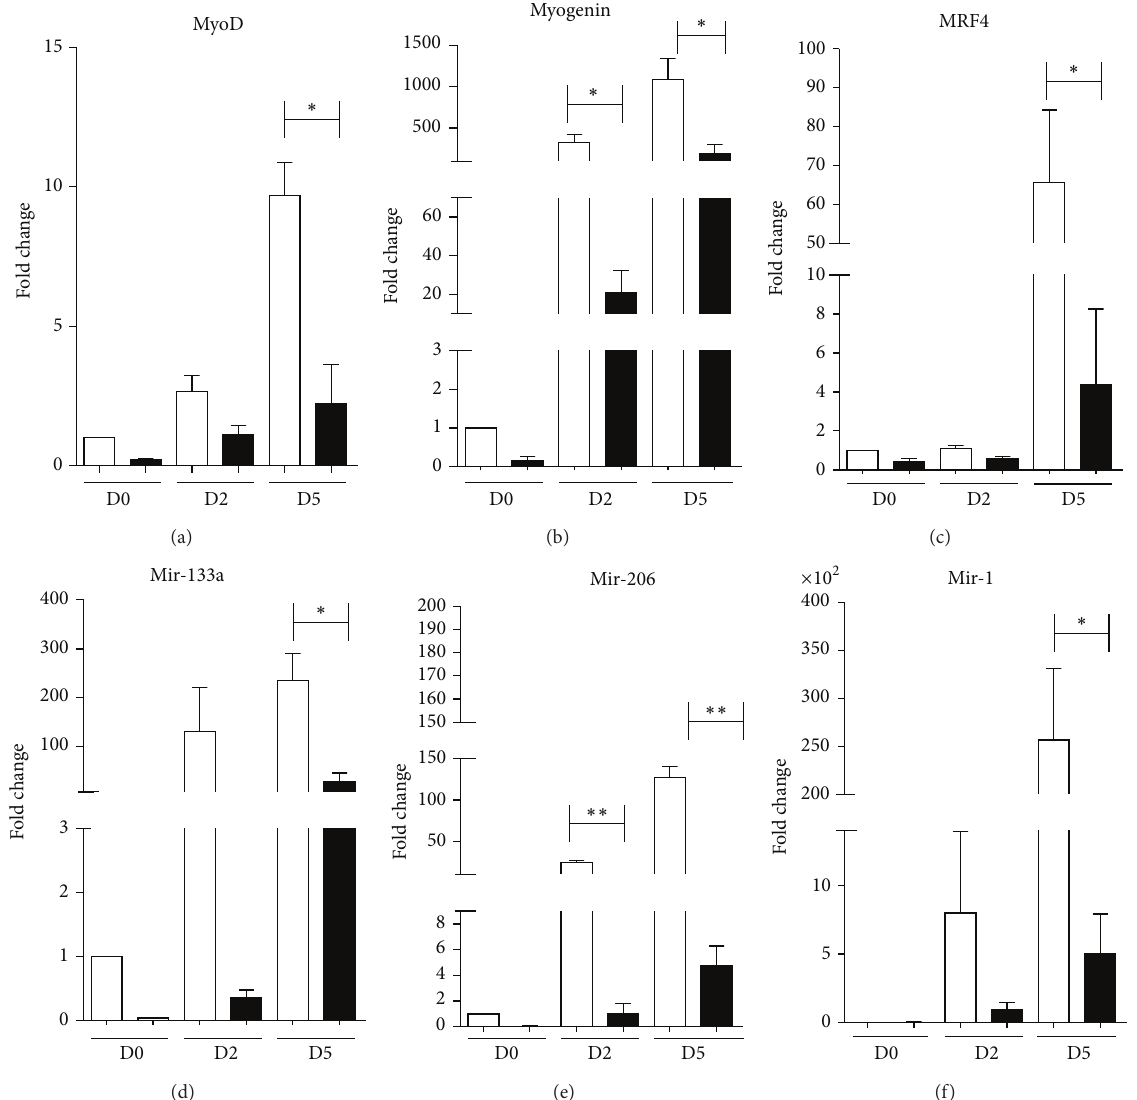
Figure 3: Mutant SOD1 gene downmodulates the players involved in C2C12 differentiation. Real time PCR for MyoD (a), Myogenin (b), MRF4 (c), miR133a (d), miR206 (e), and miR1 (f) in both control (white bars) and transfected cells (black bars). D0, D2, and D5 referred to days of culture in differentiation condition. Data are represented as mean ± SEM ( ∗ 𝑃 < 0.05 ; ∗∗ 𝑃 < 0.005